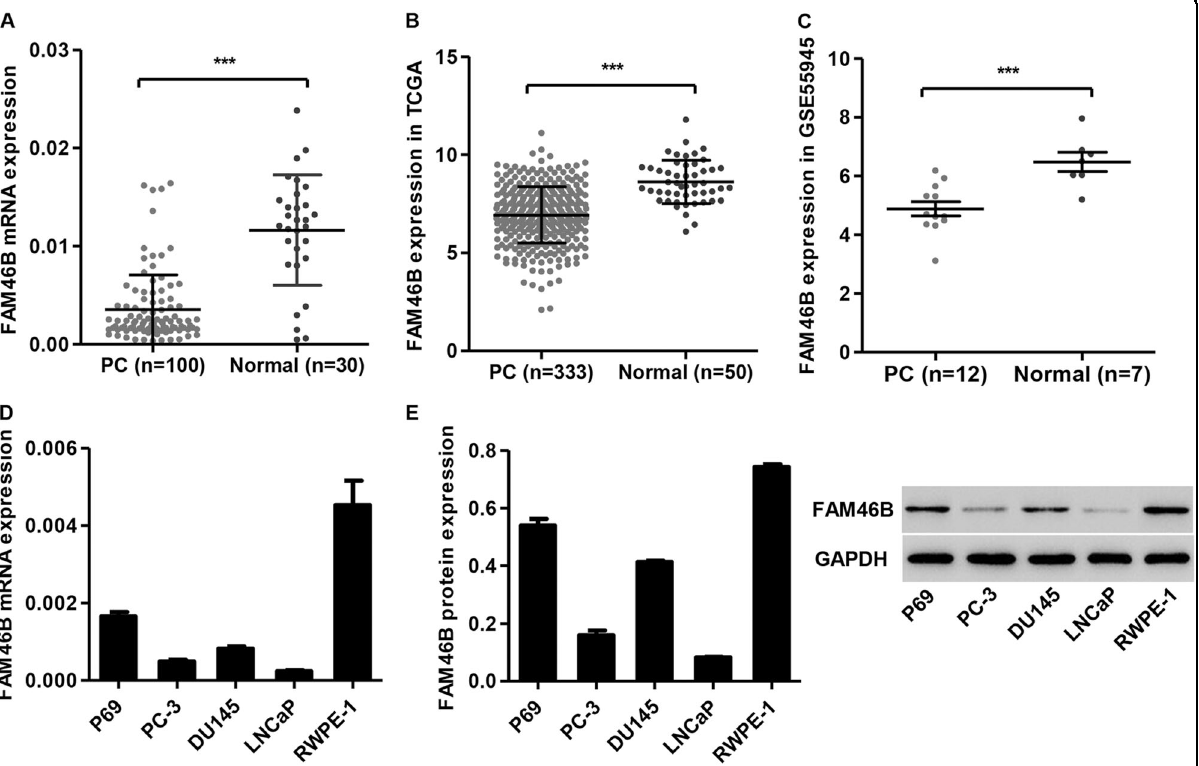
Fig. 1 FAM46B expression in PC tissues and cell lines The mRNA expression of FAM46B in PC tissues and corresponding normal prostate tissues collected from an independent hospital a , TCGA b , and the GSE55945 c data set was measured by real-time PCR and bioinformatics analysis. The FAM46B mRNA and protein expression in PC cell lines and prostate epithelial cell lines was measured by real-time PCR d and western blotting